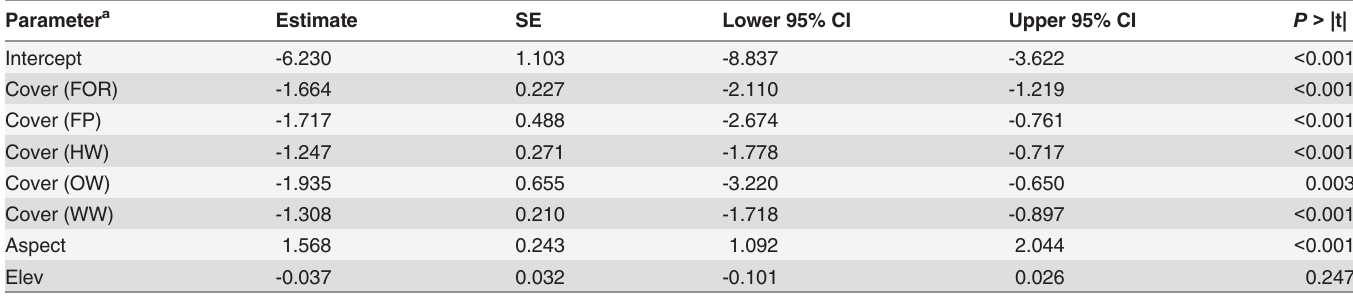
Table 4. Parameter estimates and 95% confidence intervals (CI) for the top-ranking model of eastern diamondback rattlesnake habitat selection at the home range scale in the South Carolina Coastal Plain tidewater region.